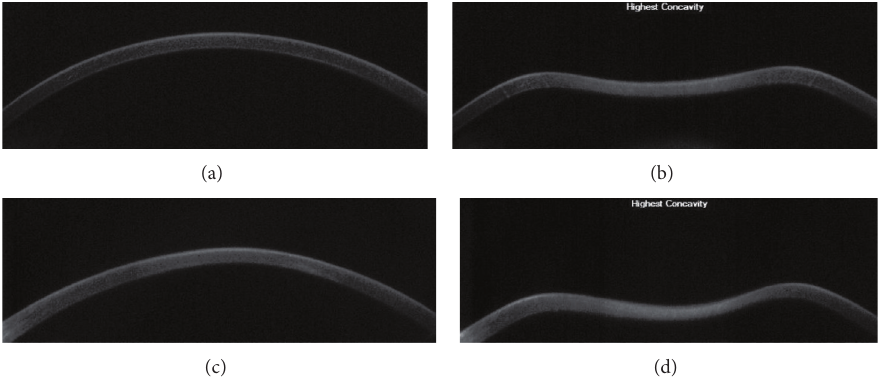
Figure 1: Cornea at stasis and maximum concavity in normal ((a) and (b)) and keratoconic ((c) and (d)) corneas. The convexity of the cornea at stasis and DA at maximum concavity is greater in the keratoconus than the normal corneas.